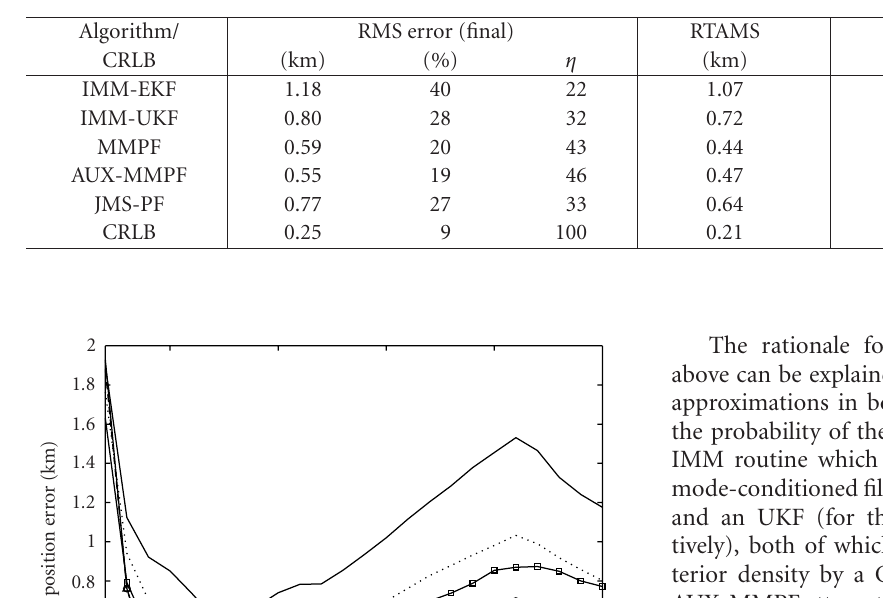
Table 1: Performance comparison for the single-sensor case.